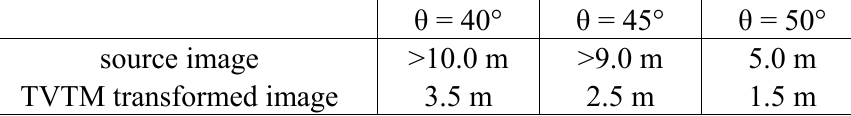
Table 1. The effective depth of source image and its TVTM